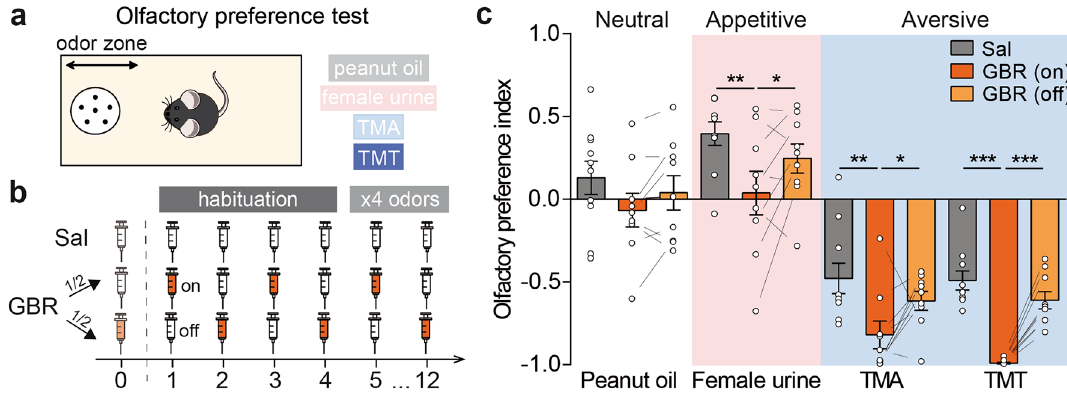
Figure 3. The GBR mice model exhibit acute negative hedonic biases in olfactory preference test. ( a ) Scheme of the olfactory preference test protocol. After 4 days of habituation, each odor was presented on two consecutive days. Peanut oil and female urine are used as innate neutral and attractive odors, respectively. TMA (trimethylamine) and TMT (trimethylthiazoline) are synthetic predator odors triggering innate aversion. ( b ) Timeline of the injections. GBR-treated mice were divided into two groups, altenatively injected each day with either Sal or GBR. ( c ) The olfactory preference index, calculated with time spent in the odor zone during odor presentation relative to habituation is a proxy for the valence attributed to each odor by the mice. In our experiments, the peanut oil was neutral in Sal-treated mice (Student test vs a theoretical value 0, t = 1.265, df = 9, p = 0.238, n = 10; see also Supplementary Table 1). GBR (on) mice exhibited a lower olfactory preference index than Sal mice for all non-neutral odors, meaning a decreased attractiveness of the female urine odor,